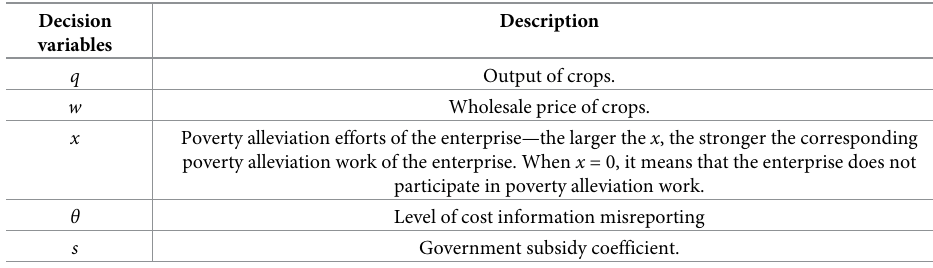
Table 2. Decision variables